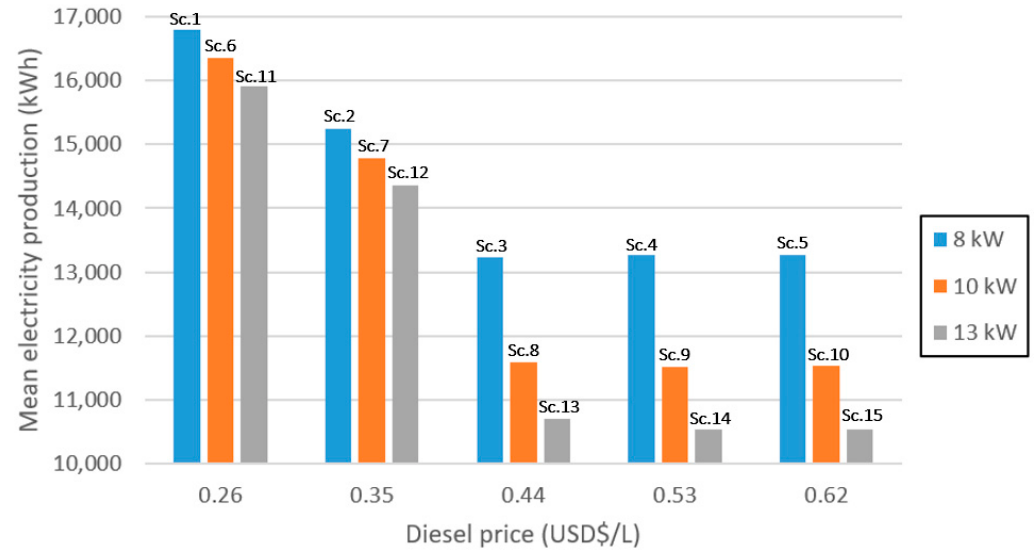
Figure 6. Mean electricity production of diesel generator (DG) over 15-year project period considering fuel prices and SPS sizes.